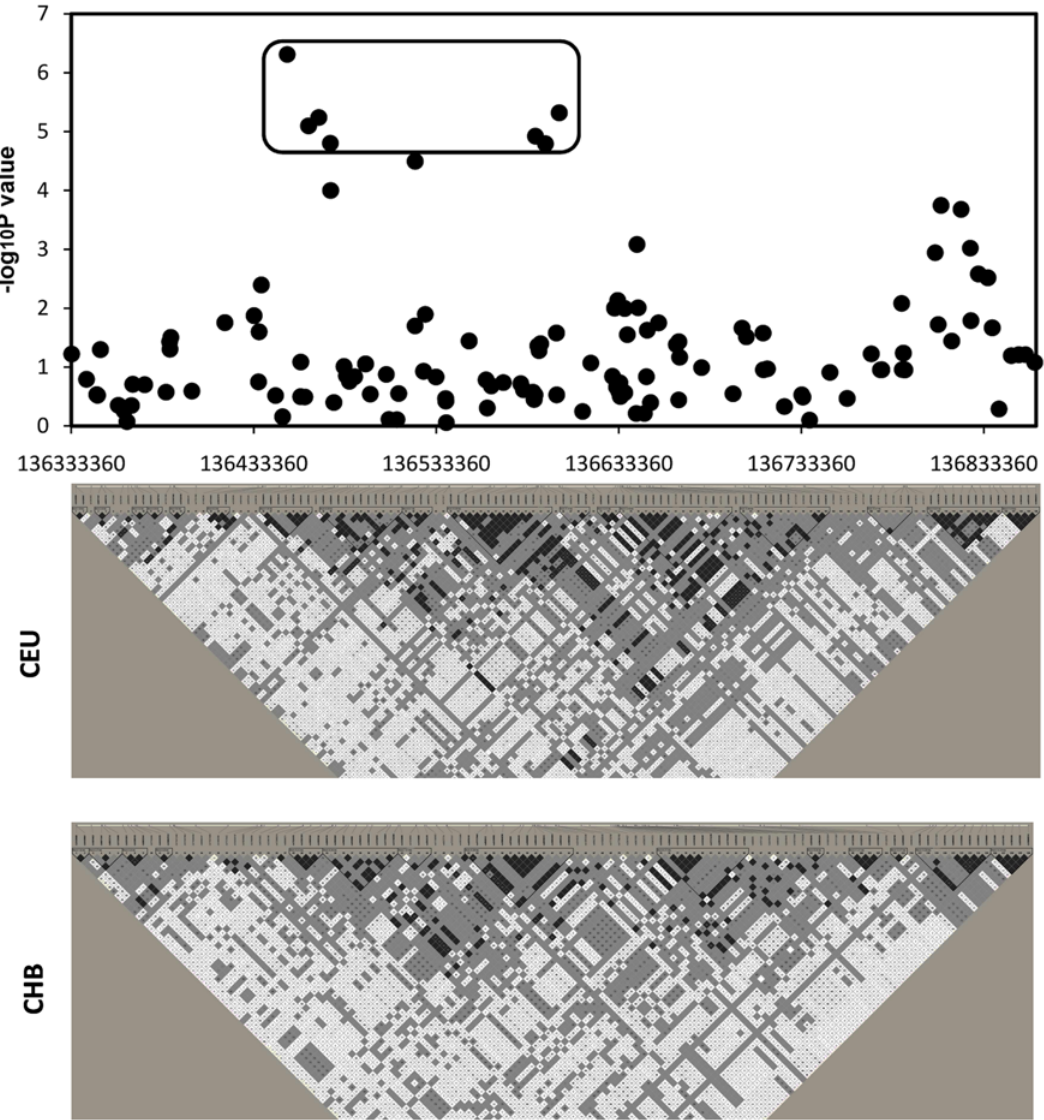
Figure 1. Association signals of the SPOCK gene SNPs. This figure depicts association signals achieved in Caucasians for all the genotyped SNPs of the SPOCK gene in our GWAS. The X axis shows the physical position of each SNP. The haplotype block map for the whole span of the SPOCK gene, showing pairwise LD in D 9 , was constructed for both Caucasians (CEU) and Chinese Han (CHB) using the Haploview program [54] (http://www.broad. mit.edu/mpg/haploview/) and the most recent SNP genotype data (HapMap Data Rel 26/phaseIII Nov 08, on NCBI B36 assembly, dbSNP b126) from HapMap (www.hapmap.org). The seven SNPs circled within the rounded rectangle are those achieving significant genome-wide FDR values ( q , 0.05), which are further illustrated in Figure